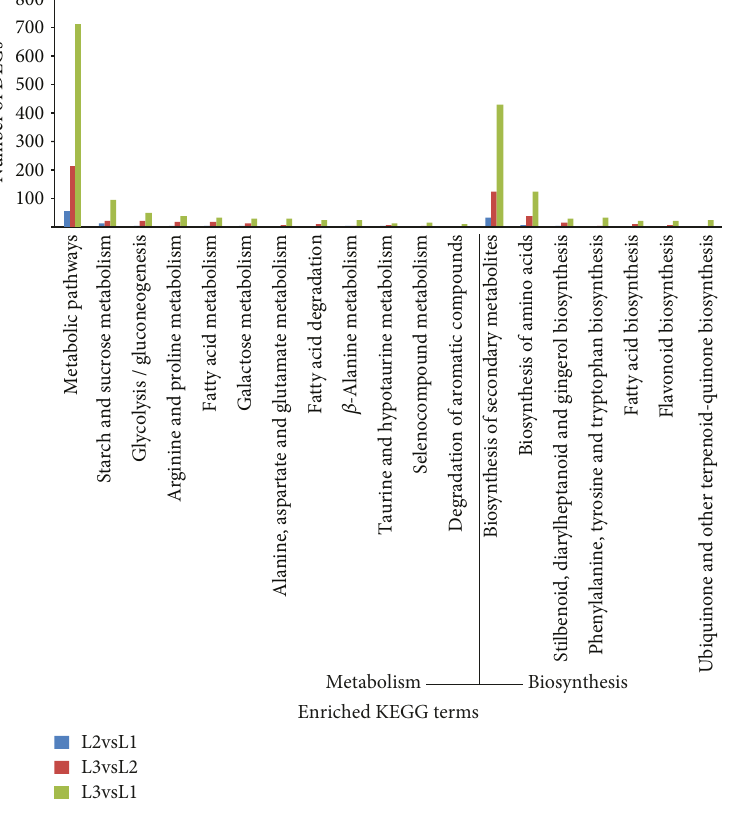
Figure 5: KEGG enrichment analysis of di ff erentially expressed genes among di ff erent samples. Table 5: KEGG analysis of di ff erentially expressed genes in lipid